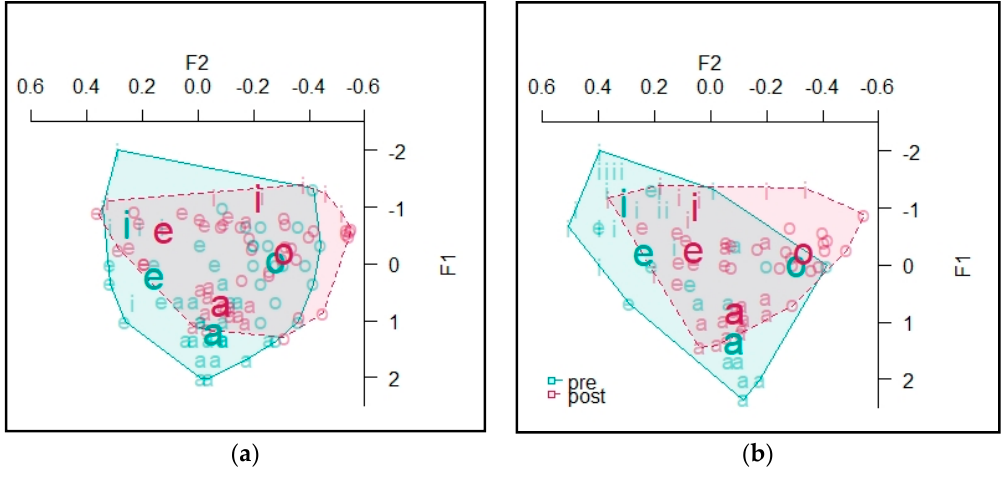
Figure 7. Informant A vowel spaces from pre-semester and post-semester measurements: ( a ) vowels from unstressed syllables; ( b ) vowels from stressed syllables.